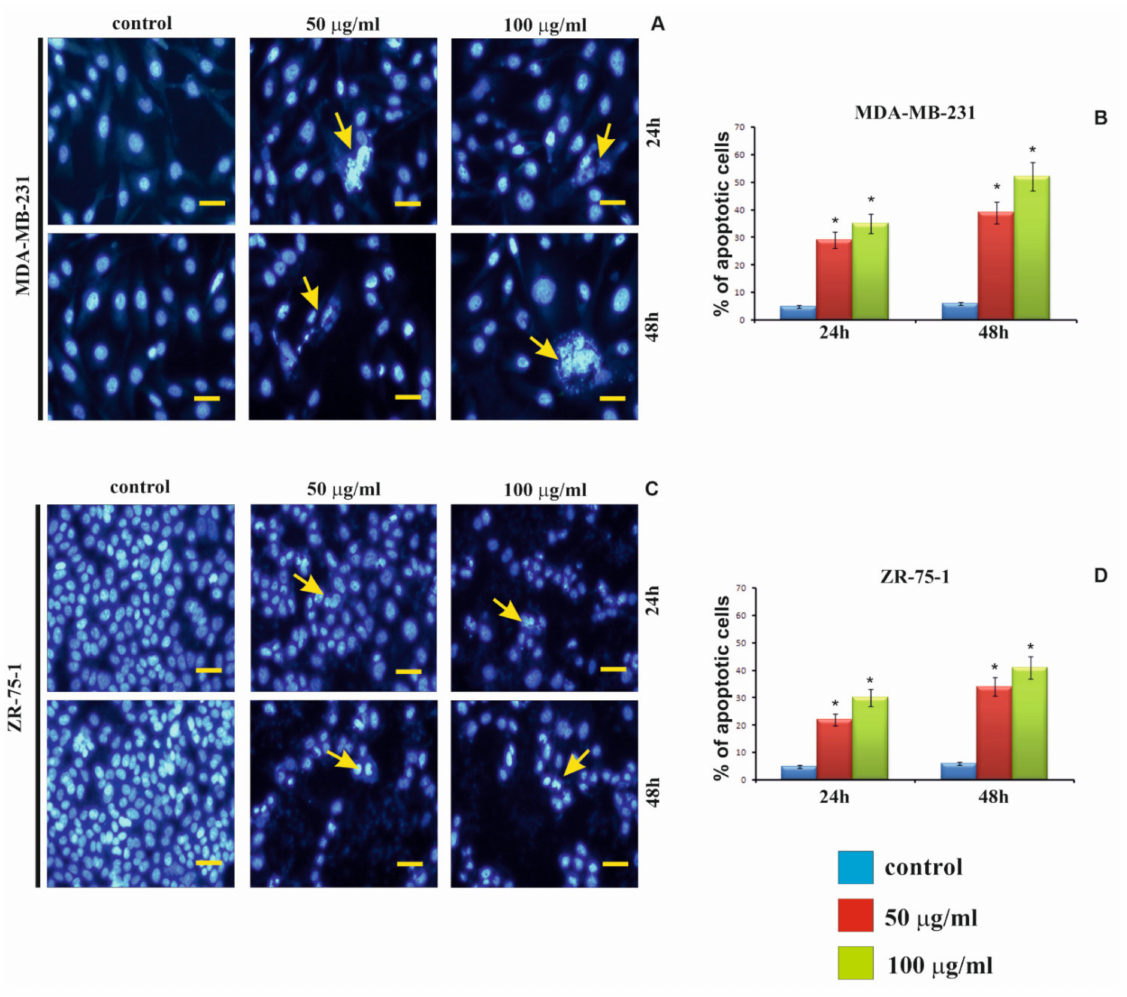
Figure 4. The effect of rGO on apoptosis in the MDA-MB-231 ( A , B ) and ZR-75-1 ( C , D ) cells was assessed by fluorescence microscopy. The cells were incubated in medium with rGO (50 µ g/mL or 100 µ g/mL) for 24 h and 48 h, next were stained with DAPI and photographed under a fluorescence microscope at 200-fold magnification and analyzed according to the following criteria: living cells-normal blue nucleus without chromatin condensation, apoptotic cells-blue stained nuclei with chromatin condensation, fragmentation or apoptotic body. We presented representative images from one of the three independent experiments. Scale bar 50 µ m. The bar graphs present the percentage of apoptotic cells—( B , D ). Significant alterations are expressed relative to controls and marked with asterisks. Statistical significance was considered if * p <